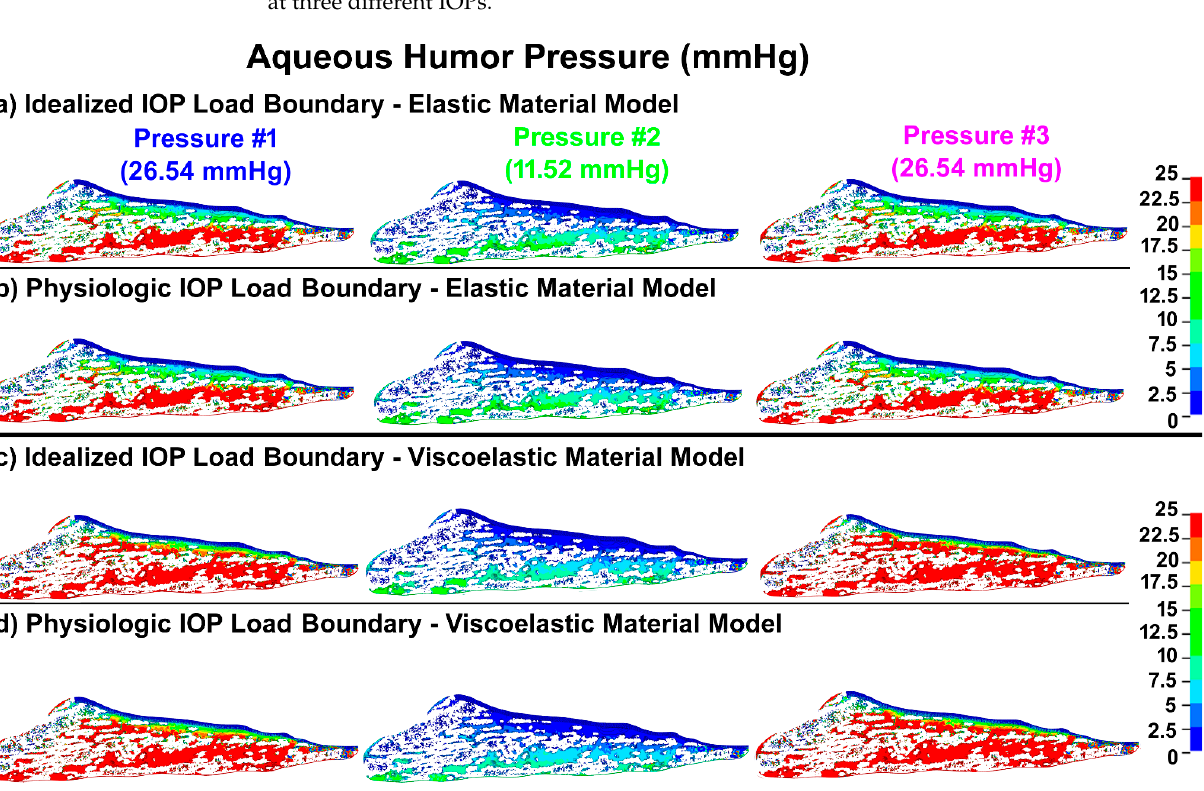
Figure 7. The pressure in the aqueous humor across the TM/JCT/SC complex with ( a ) idealized IOP load boundary (elastic material), ( b ) physiologic IOP load boundary (elastic material), ( c ) idealized IOP load boundary (viscoelastic material), and ( d ) physiologic IOP load boundary (viscoelastic material) at three different IOPs. The resultant displacement in the TM/JCT/SC complex at the IOP of 10 mmHg is shown in Figure 8.